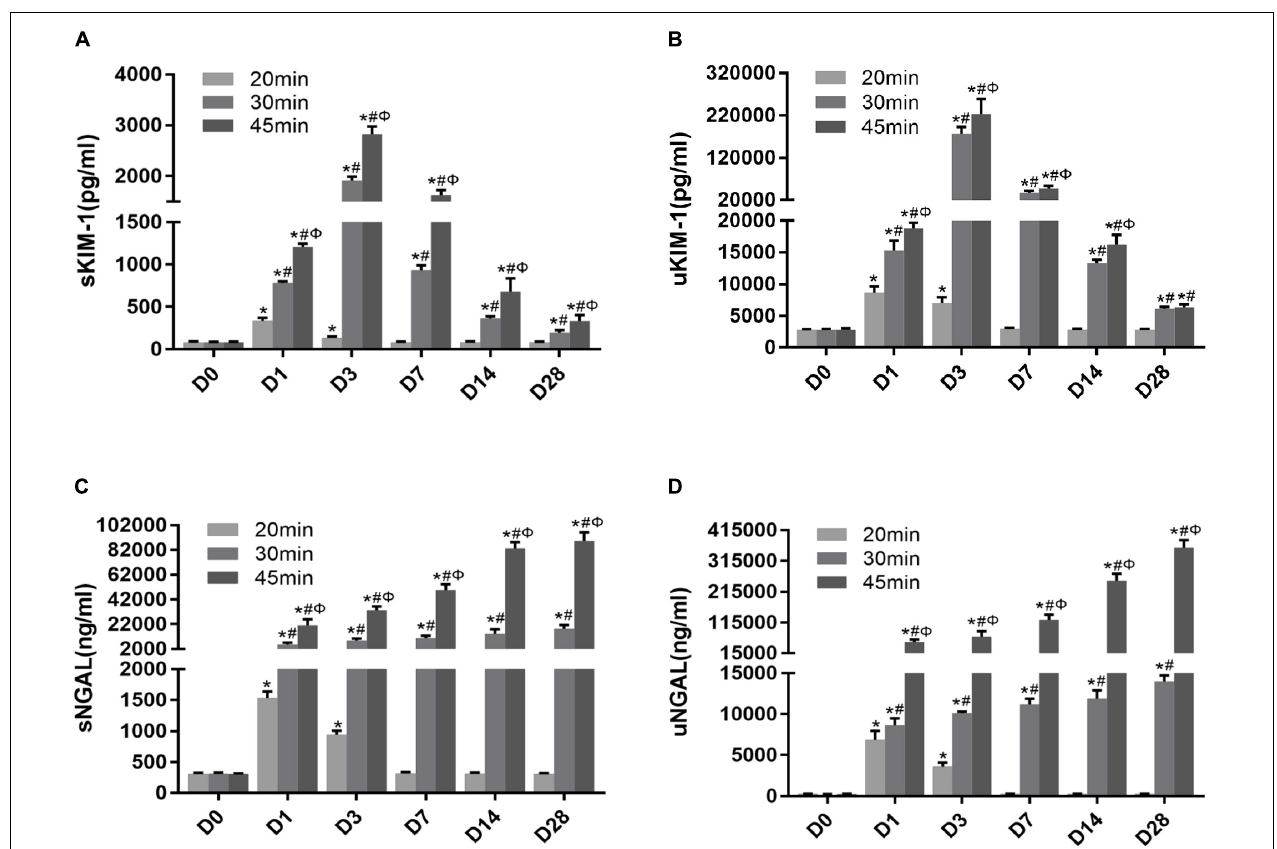
FIGURE 8 | Novel AKI biomarkers KIM-1 and NGAL enabled the noninvasive and early detection of AKI. (A–D) Tubular injury biomarker changes in mice subjected to different durations of ischemia at 28 days post ischemia: (A) serum KIM-1, (B) urinary KIM-1, (C) serum NGAL, (D) urinary NGAL. Data are presented as the means ± SEM of four experiments. n = 6; ∗ P < 0.05 vs. the control group. # P < 0.05 vs. the 20-min ischemia group. (cid:56) P < 0.05 vs. the 30-min ischemia